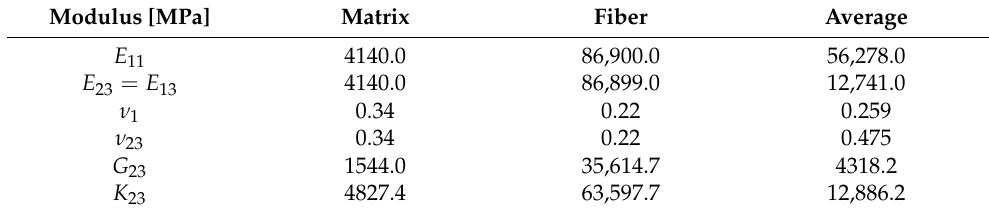
Table 2. Computed values of elastic moduli (Case 1).